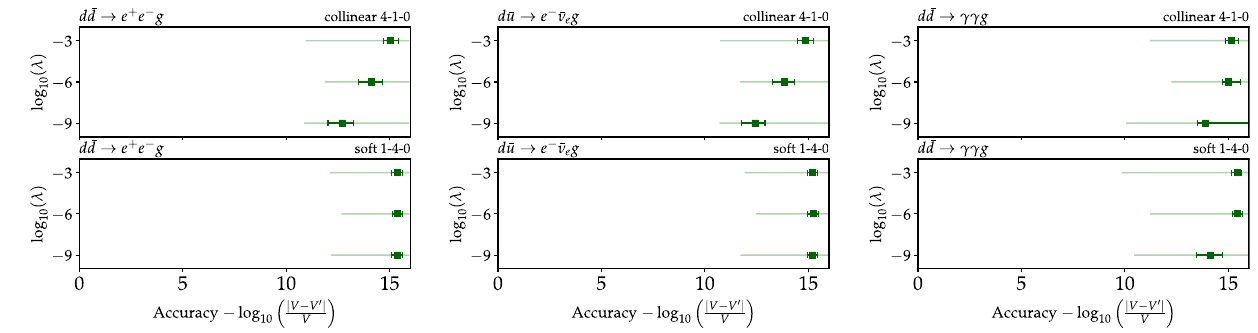
Fig. 3 Test of the numerical accuracy of standard-model three-parton one-loop amplitudes in the soft and collinear limits